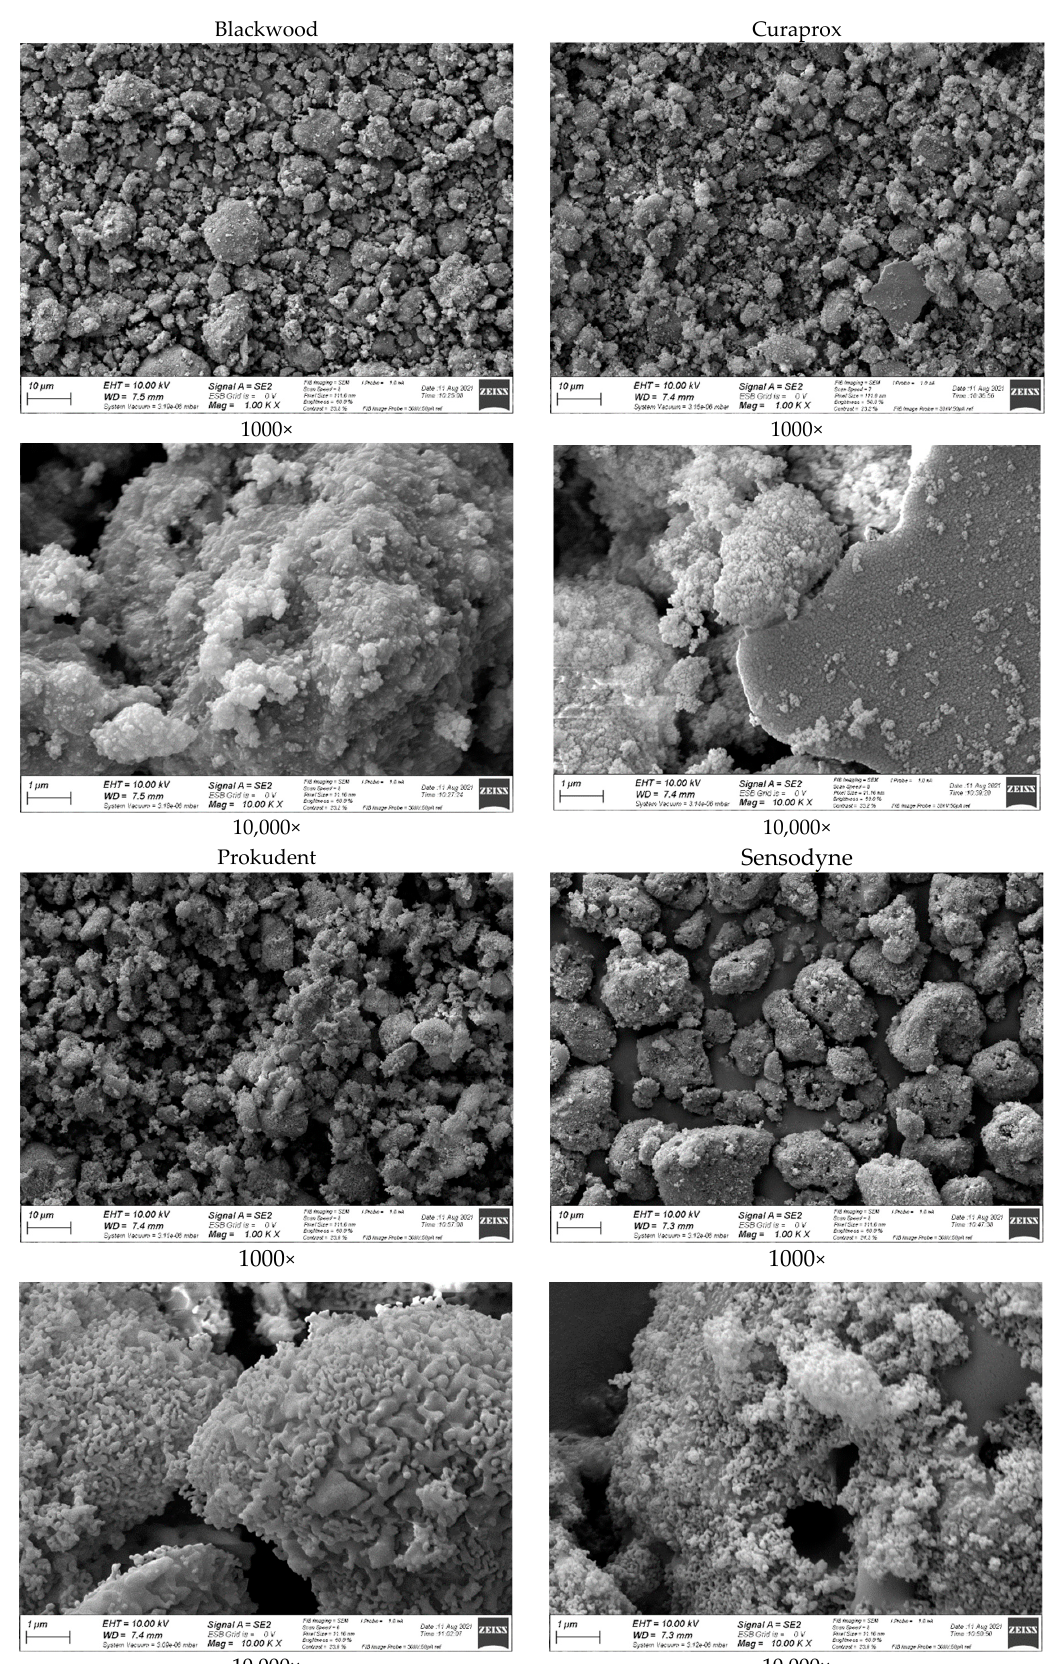
Figure 3. SEM micrographs of inorganic residues (silica) after